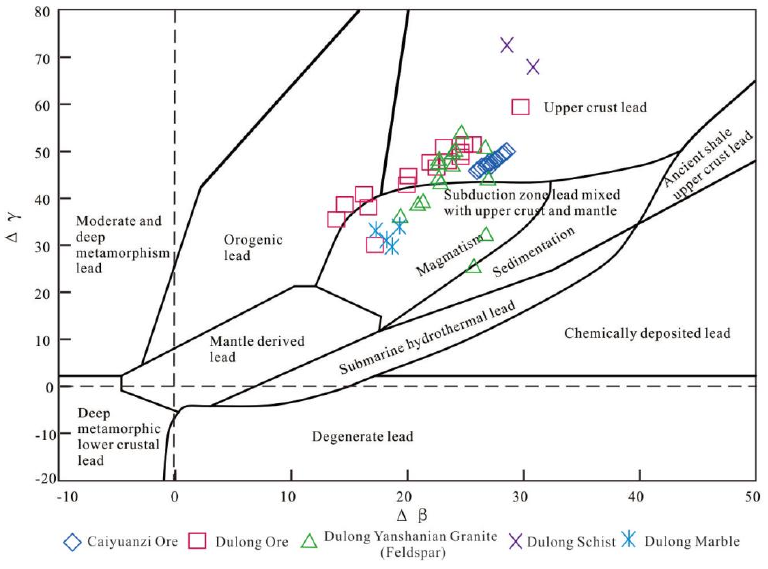
Figure 10. Lead isotope Δβ - Δγ genetic classification diagram (base map is modeled after [55], and lead isotope data of samples in the Dulong ore area are quoted from [43]).